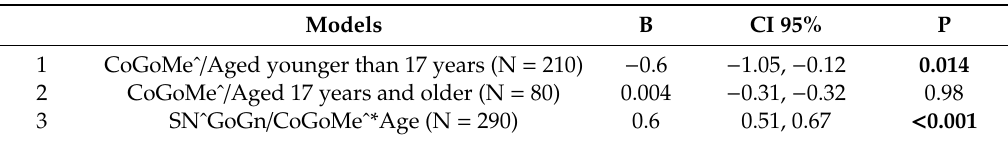
Table 3. Distribution of the CoGoMeˆ according to the ANPgˆ and the SNˆGoGn. Di ff erences in CoGoMeˆ among individuals with di ff erent ANPgˆ and SNˆGoGn were estimated as appropriate using one-way ANOVA. Bold text indicates statistically significant